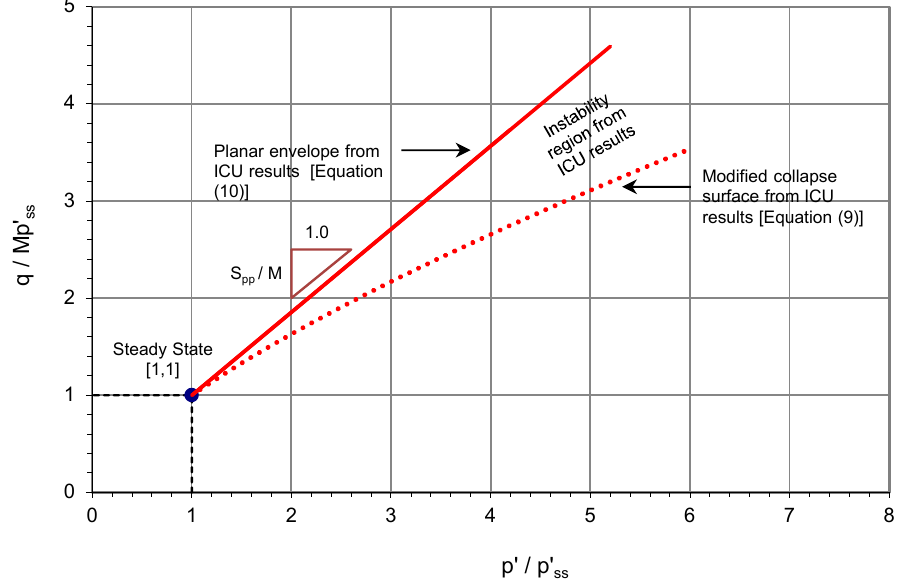
Figure 9. Instability region in normalized space from the ICU test results.